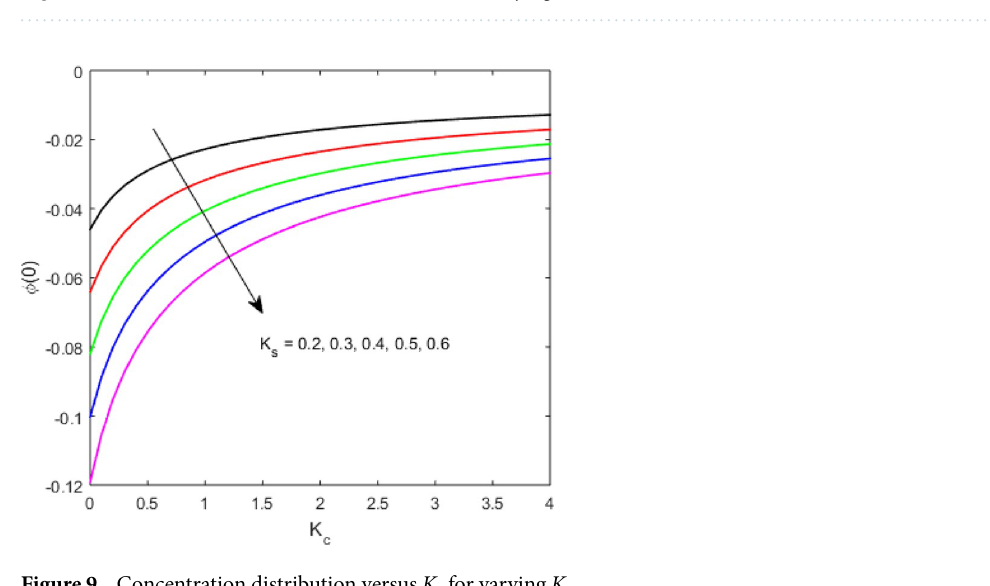
Figure 8. Concentration distribution versus K vs for varying K s .